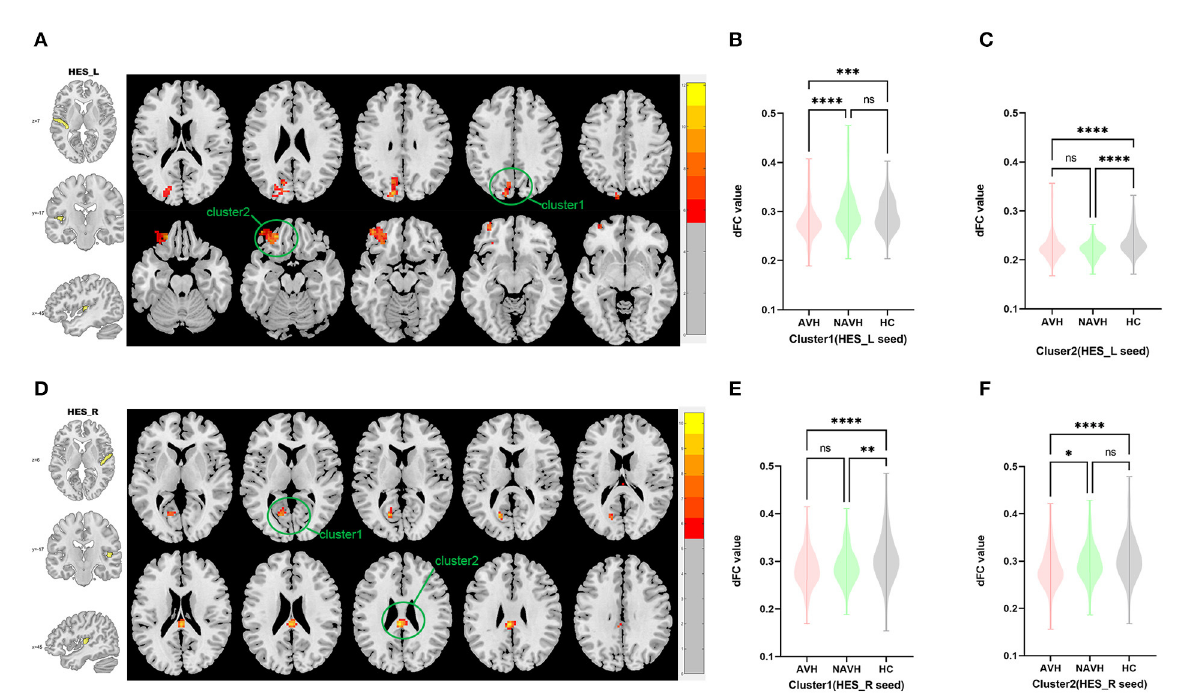
FIGURE2 Brain regions showing abnormal dFC values among AVH, NAVH and HC groups in MNI space using left and right HES as seeds. (A) Significant dFC value differences were observed in cluster1 (left superior occipital gyrus, left cuneus gyrus, left precuneus gyrus) and cluster2 (left anterior orbitofrontal gyrus) using left HES as seed. (B,C) Altered dFC values in cluster1 and cluster2 among AVH, NAVH and HC groups using left HES as seed. (D) Significant dFC value differences were observed in cluster1 (left calcarine gyrus) and cluster2 (posterior cingulate gyrus.) using right HES as seed. (E,F) Altered dFC values in cluster1 among AVH, NAVH and HC groups using right HES as seed. ****Significant at 0.0001 level, ***significant at 0.001 level, **significant at 0.01 level and *significant at 0.05 level